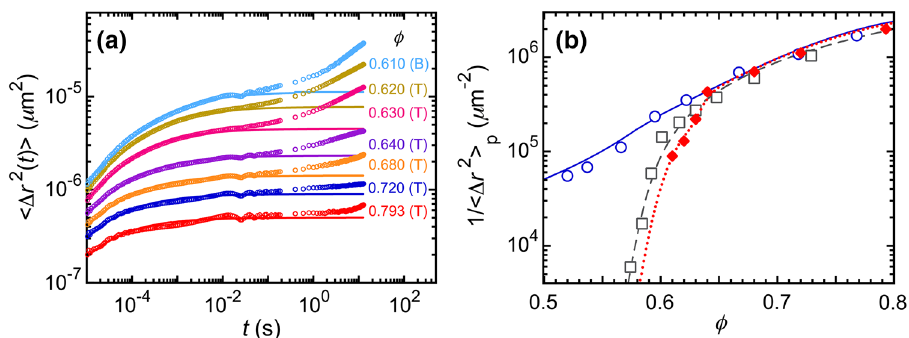
Figure 3. Time-dependent DWS mean square displacements (MSDs), (cid:31) � r 2 ( t ) (cid:30) , and inverse primary plateau MSDs, 1/ (cid:31) (cid:31) r 2 (cid:30) p , as a function of φ . ( a ) Ensemble-averaged (cid:31) � r 2 ( t ) (cid:30) for a series of different φ , extracted from g 2 ( t ) − 1 in Fig. 2 and corrected for collective scattering using 1 /ℓ ∗ IA in Fig. 1. Rises in the MSDs at long times are attributed to excess MSDs 59 , which do not reflect average probe dynamics. DWS MSDs at early- to-intermediate times are fit to an emulsion model, developed for nearly hard droplet interactions by Kim et al. 47 . Fits (solid lines) provide plateau self-motion probe MSDs, (cid:31) (cid:31) r 2 (cid:30) p . (T) and (B) indicate transmission and backscattering geometries, respectively. ( b ) 1/ (cid:31) � r 2 (φ) (cid:30) p for emulsion systems having different types of interactions between droplets. Intermediate attractions (this study): 1/ (cid:31) (cid:31) r 2 (cid:30) p,IA (red diamonds), obtained from long-time plateau values of the fits in part (a). Dotted line: prediction curve with a smooth transition between an analytical interpolation of measured 1/ (cid:31) (cid:31) r 2 (cid:30) p,IA for φ ≥ 0.61, and the rescaled calculation using the EEI model 27 and GSER for φ < 0.61. Nearly hard interactions (Kim et al. 47 ): 1/ (cid:31) (cid:31) r 2 (cid:30) p,NH (gray squares, dashed line: fit using the EEI model and GSER). Strong attractions (Xu et al. 60 ): 1/ (cid:31) (cid:31) r 2 (cid:30) p,SA (blue circles, solid line: analytical